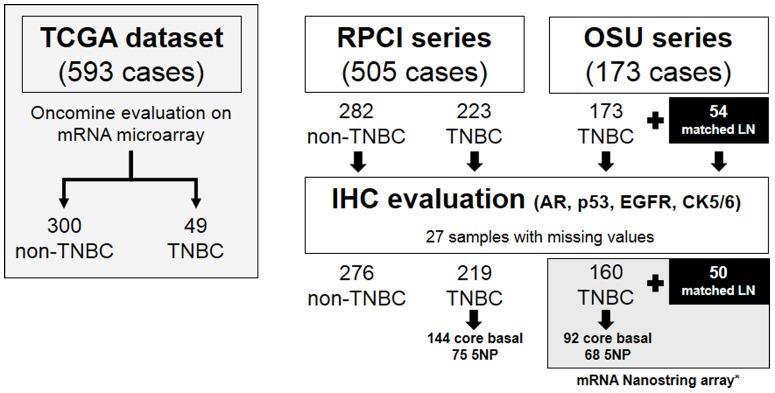
Overview of the cohorts examined and molecular tests applied.* All the 54 lymph node metastases were analyzed by Nanostring mRNA array.